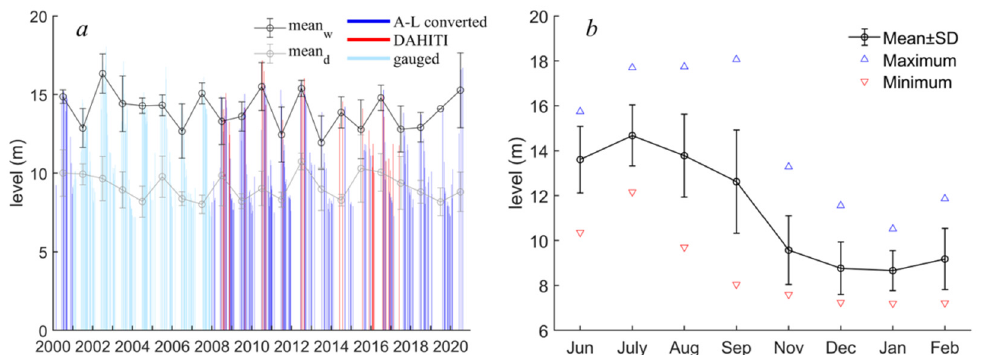
Figure 9. The fluctuations of the lake level from the gauged observations, results converted from DAHITI records, and results converted from the area–level relationship ( a ) and its seasonal variations ( b ).